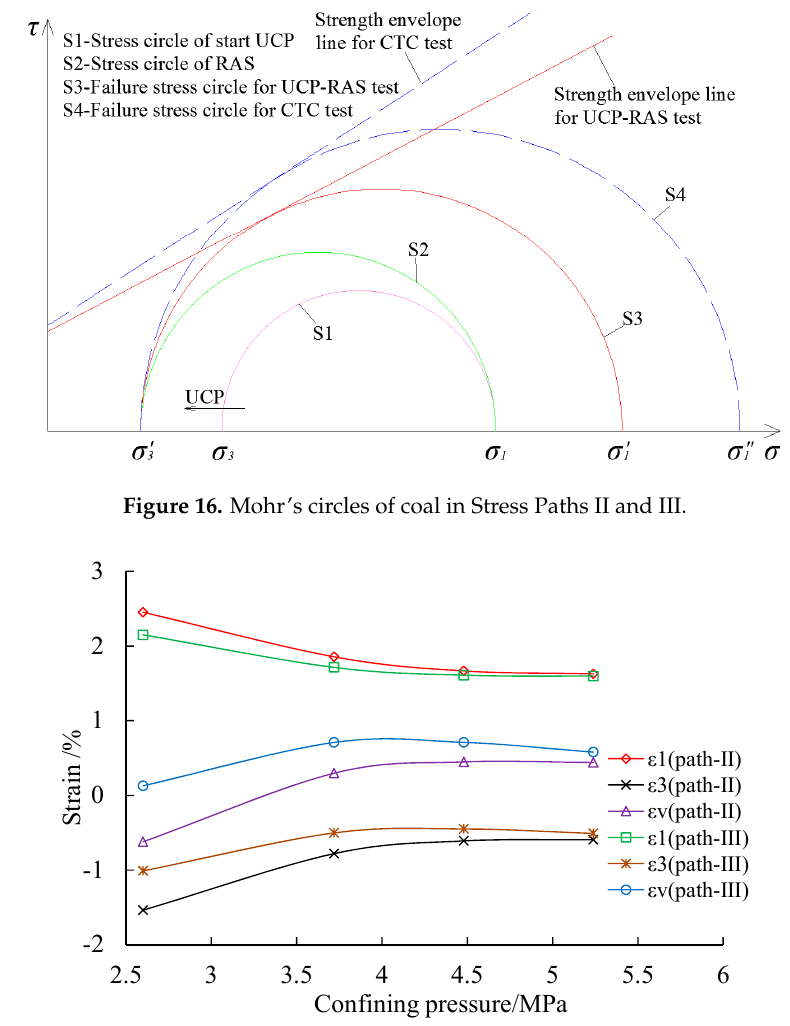
Figure 17. Strain of coal specimens under the stress state of Stress Circle S1.